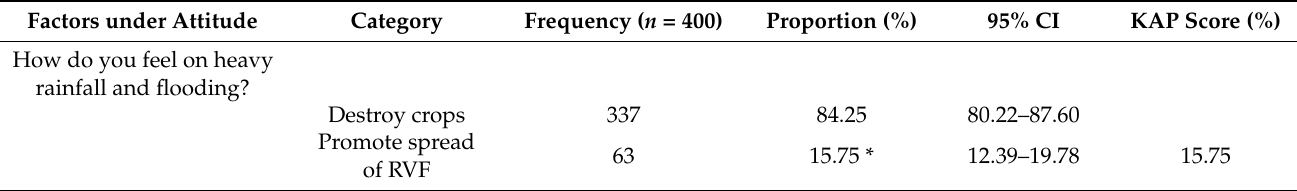
Table 4. Attitudes of participants towards Rift Valley